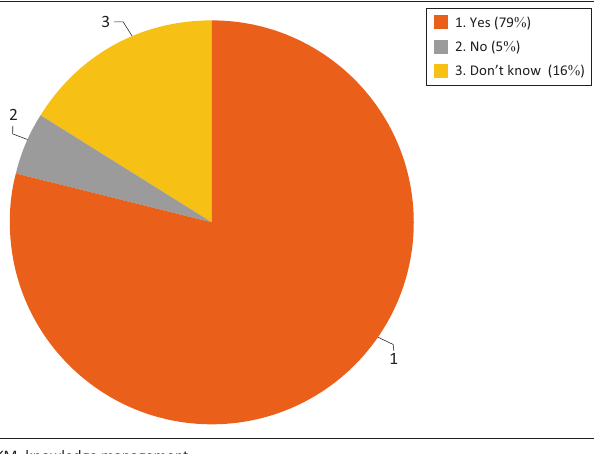
1. Yes (79 % ) 2. No (5 %